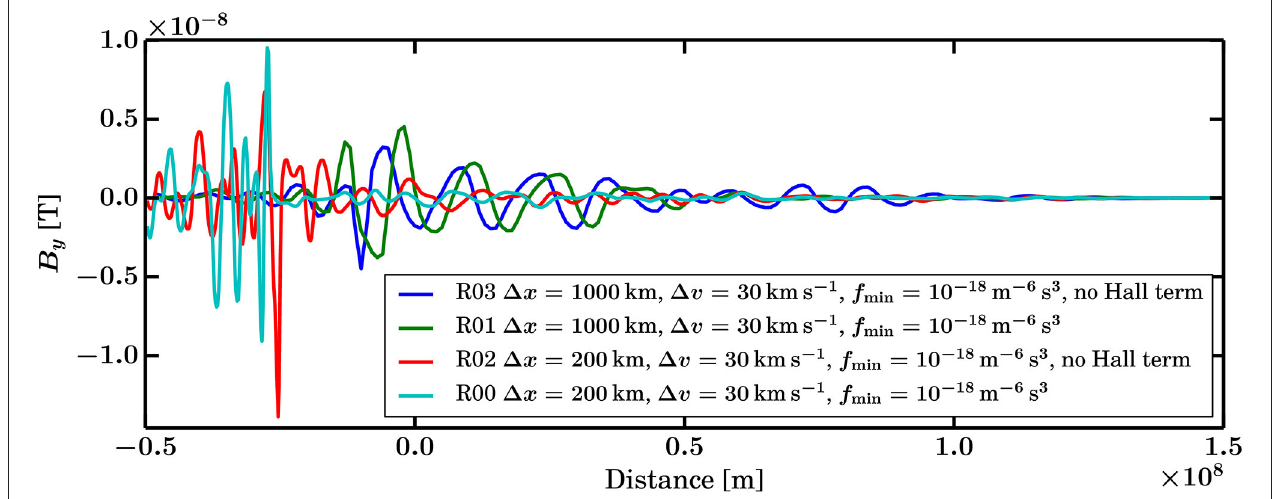
FIGURE 6 | Magnetic field B y profiles for Runs R03, R01, R02, and R00 showing the effect of the Hall term in Ohm’s law in the field